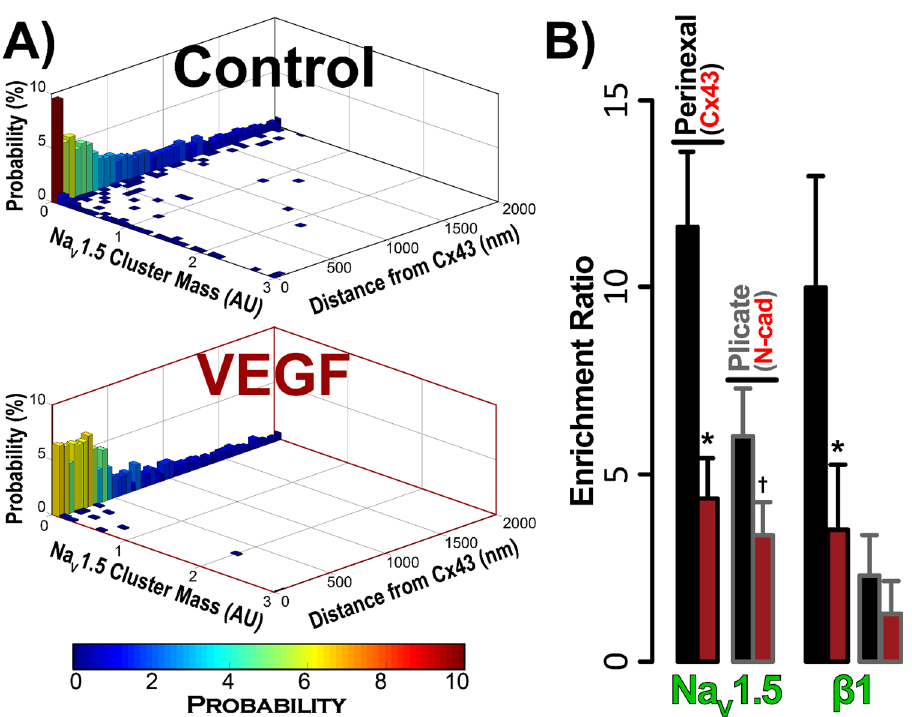
Figure 6. OBS3D analysis of STED images. ( A ) Bivariate histograms of Na V 1.5 cluster mass (normalized intensity summed over the cluster) as a function of distance from Cx43 clusters. These provide representative examples of intermediate steps in image analysis involved in assessing enrichment ratios, calculated as the ratio of Na V 1.5/β1 immunosignal cluster mass (volume x normalized intensity) at sites near (< 100 nm away) Cx43 (GJ) and N-cad (MJ) clusters vs. the signal cluster mass at other ID sites. ( B ) Summary plots of enrichment ratio (n = 3 hearts/group, 3 images/heart; * p < 0.05 vs.